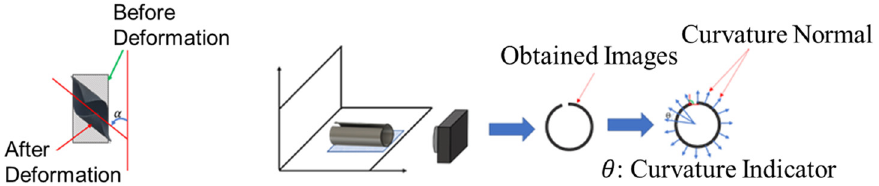
Figure 4. Bending Angle Measuring and Curvature Measurement Workflow.